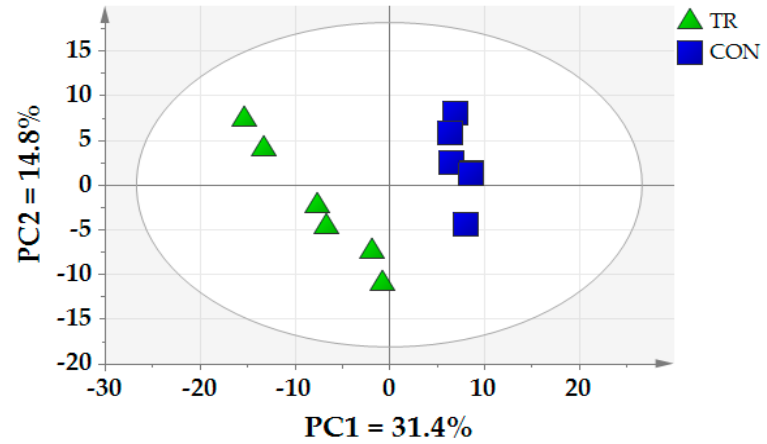
Figure 4. Principal component analysis (PCA) of ruminal metabolites of CON and TR groups. PC1 = the first principal component; PC2 = the second principal component.